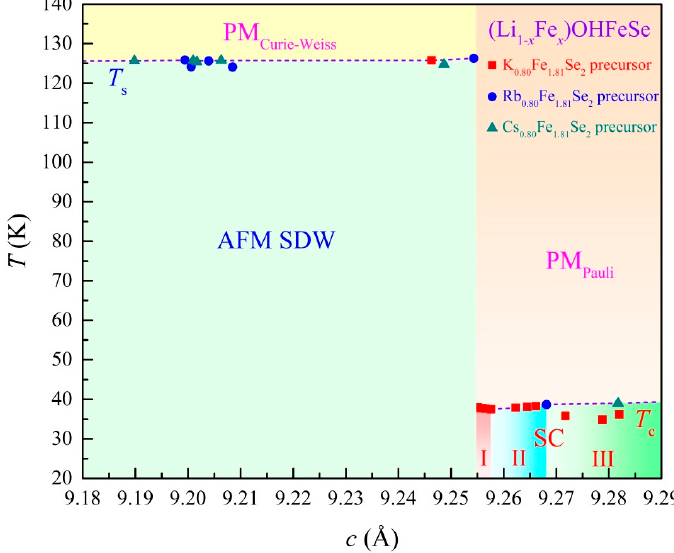
Figure 11. Phase diagram of (Li 1 − x Fe x )OHFeSe single crystals grown using A 0.80 Fe 1.81 Se 2 ( A = K, Rb, and Cs) precursors. The values of T s and T c were derived from the 4 π χ – T curves [53]. Reprinted with permission from IOP. All rights reserved.